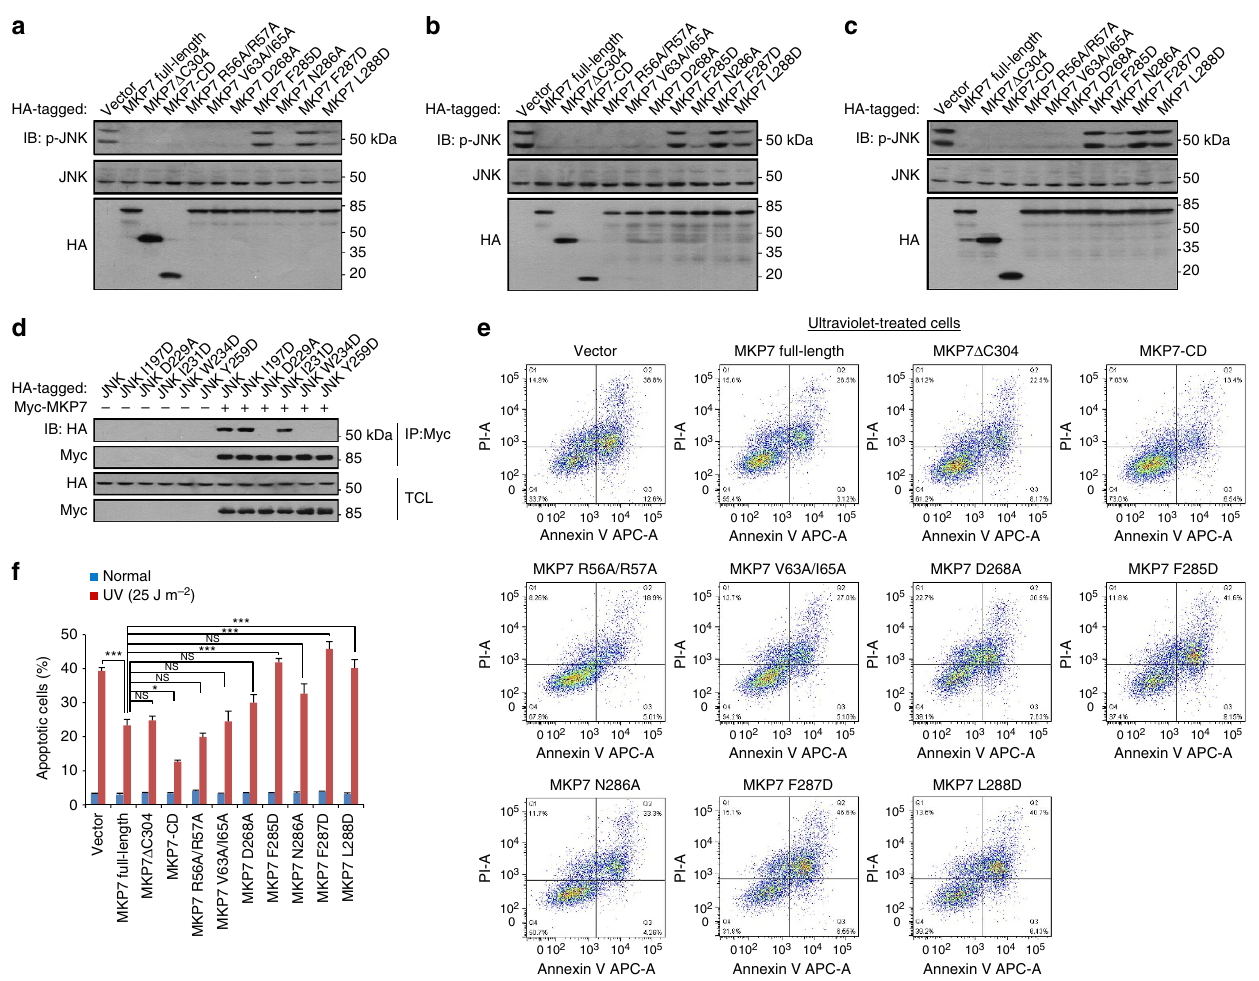
Figure 6 | FXF-motif is critical for controlling the phosphorylation of JNK and ultraviolet-induced apoptosis. ( a – c ) FXF-motif is essential for the dephosphorylation of JNK by MKP7. HEK293T cells were infected with lentiviruses expressing MKP7 and its mutants (1.0 m g). After 36h infection, cells were untreated in a , stimulated with 30 m M etoposide for 3h in b or irradiated with 25Jm (cid:3) 2 ultraviolet light at 30min before lysis in c . Whole-cell extracts were then immunoblotted with antibody indicated. Shown is a typical immunoblot for phosphorylated JNK from three independent experiments. ( d ) F-site is required for JNK1 to interact with MKP7. HEK293Tcells were co-transfected with MKP7 full-length (1.0 m g) and JNK1 (wild type or mutants as indicated, 1.0 m g). At 16h post transfection, cells were lysed. Whole-cell extracts were then immunoprecipitated with antibody against Myc for MKP7; immunobloting was carried out with antibodies indicated. IP, immunoprecipitation; TCL, total cell lysate. Shown is a typical result from three independent experiments. ( e ) Effect of MKP7 (wild type or mutants) expression on ultraviolet-induced apoptosis. HeLa cells were infected with lentiviruses expressing MKP7 full-length and its mutants. At 36h post infection, cells were irradiated with 25Jm (cid:3) 2 ultraviolet light and collected at 6h after irradiation. Cells were then subjected to flow cytometry analysis. Apoptotic cells were determined by Annexin-V-APC/PI staining. The results using Annexin-V stain for membrane phosphatidylserine eversion, combined with propidium iodide (PI) uptake to evaluate cells whose membranes had been compromised. Staining with both Annexin-V and PI indicate apoptosis (upper right quadrant). The values shown in the lower left, and upper right quadrants of each panel represent the percentage of viable, and apoptotic cells, respectively. All results are representative of three independent experiments. ( f ) Statistical analysis of apoptotic cells (mean ± s.e.m., n ¼ 3), * P o 0.05, *** P o 0.001 (ANOVA followed by Tukey’s test). NS, not